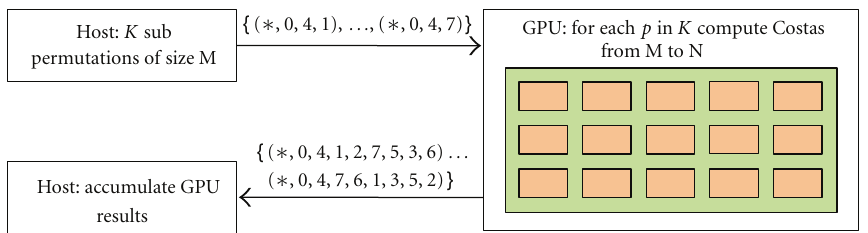
Figure 5: Simplified workflow of the GPGPU implementation. The Host generates a list of subpermutations, the GPU completes the search for the full permutations, then sends them back to the Host. The process repeats until no more subpermutations exist.